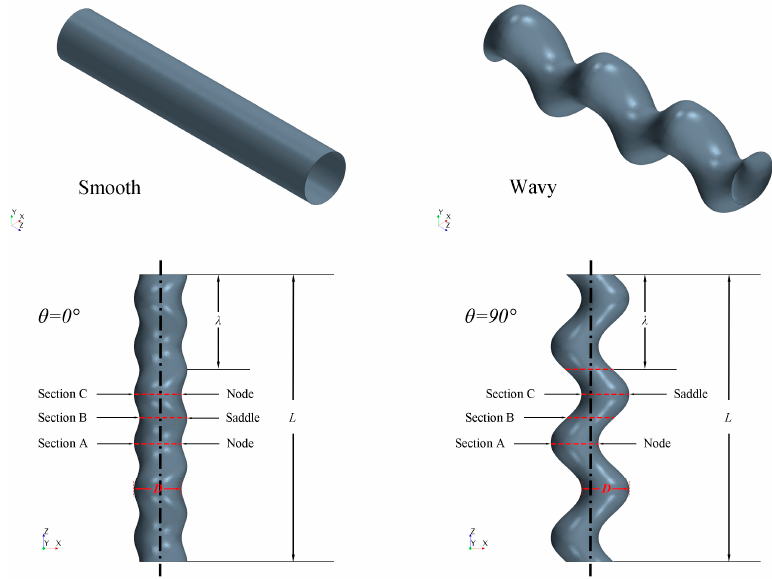
Figure 2. Smooth, wavy cylinder and its geometric definition.